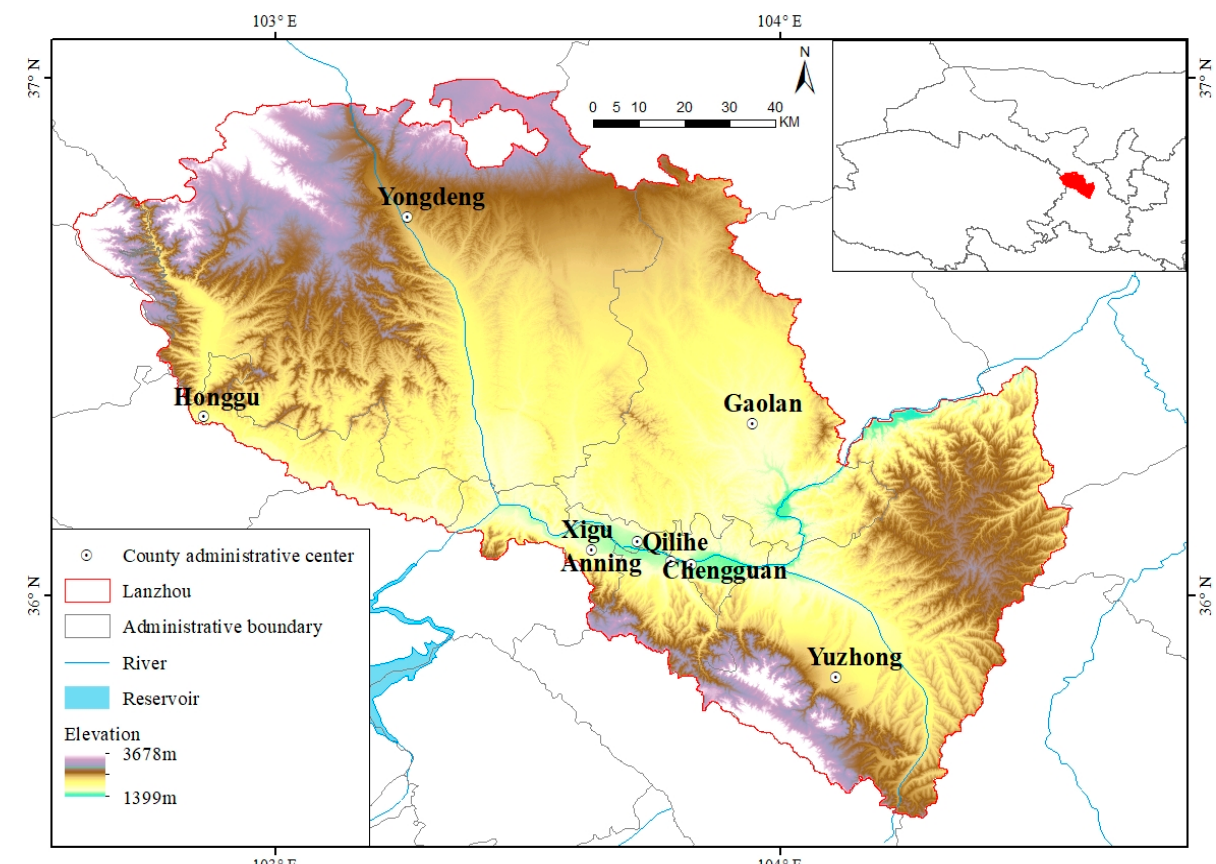
Figure 1. Elevation of the study region. Lanzhou includes five districts (Honggu, Xigu, Anning, Qilihe, and Chengguan), and three counties (Yongdeng, Gaolan, and Yuzhong).